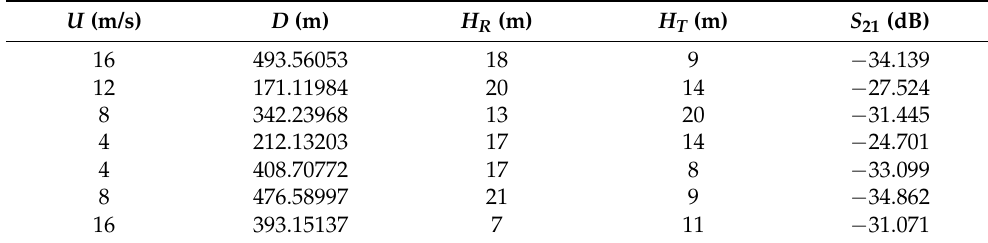
Table 3. Partial Input Sea Parameter and Output